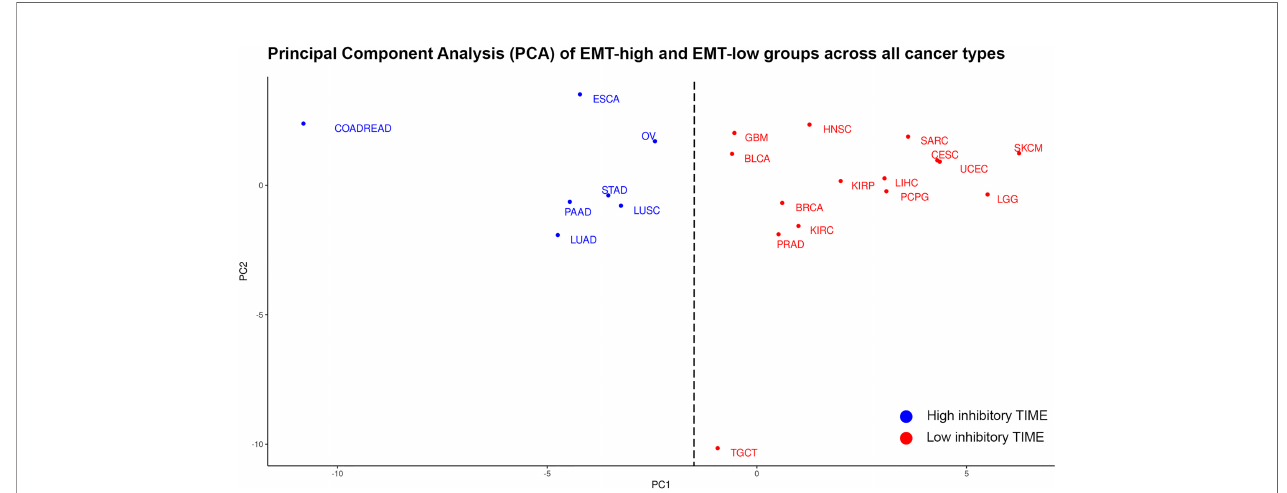
FIGURE 8 | Principal component analysis (PCA) of differences in the median values of each tumor immune microenvironment (TIME) marker between epithelial – mesenchymal transition (EMT)-high and EMT-low groups of each cancer type: Cancer types in blue are classi fi ed as having high inhibitory TIME in EMT-high tumors as compared to EMT-low, while cancer types in red are classi fi ed as having not-highly inhibitory TIME in EMT-high tumors as compared to